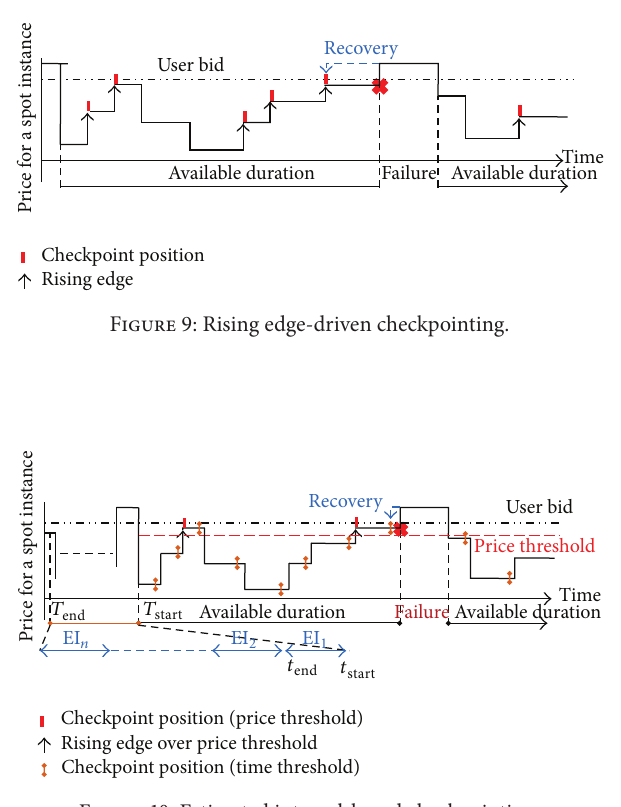
Figure 10: Estimated interval-based